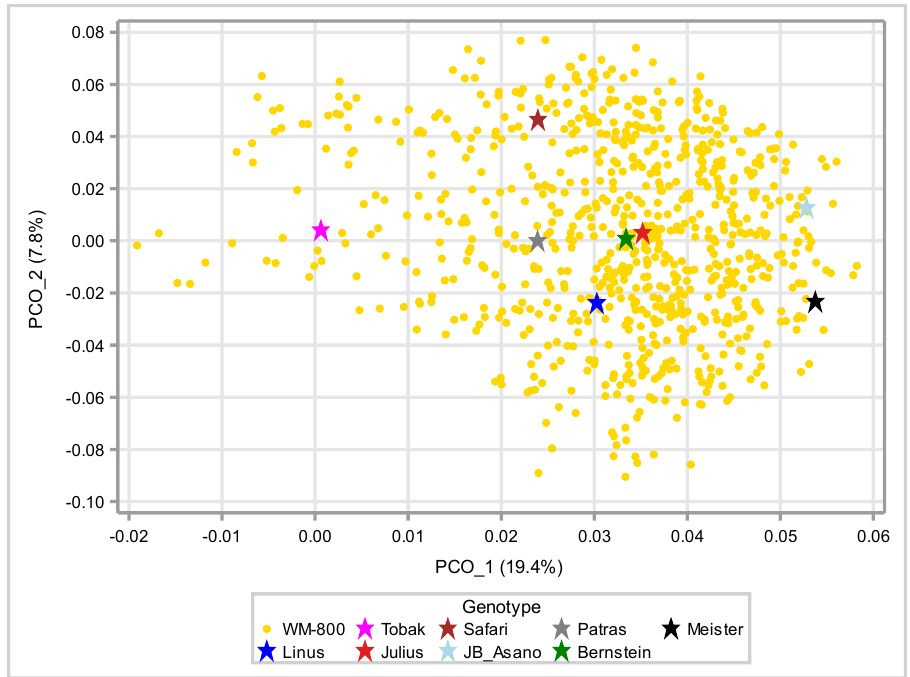
Figure 2. Visualization of the genetic diversity present in WM-800 and its eight founder lines based on a 2-dimensional principal component analysis.